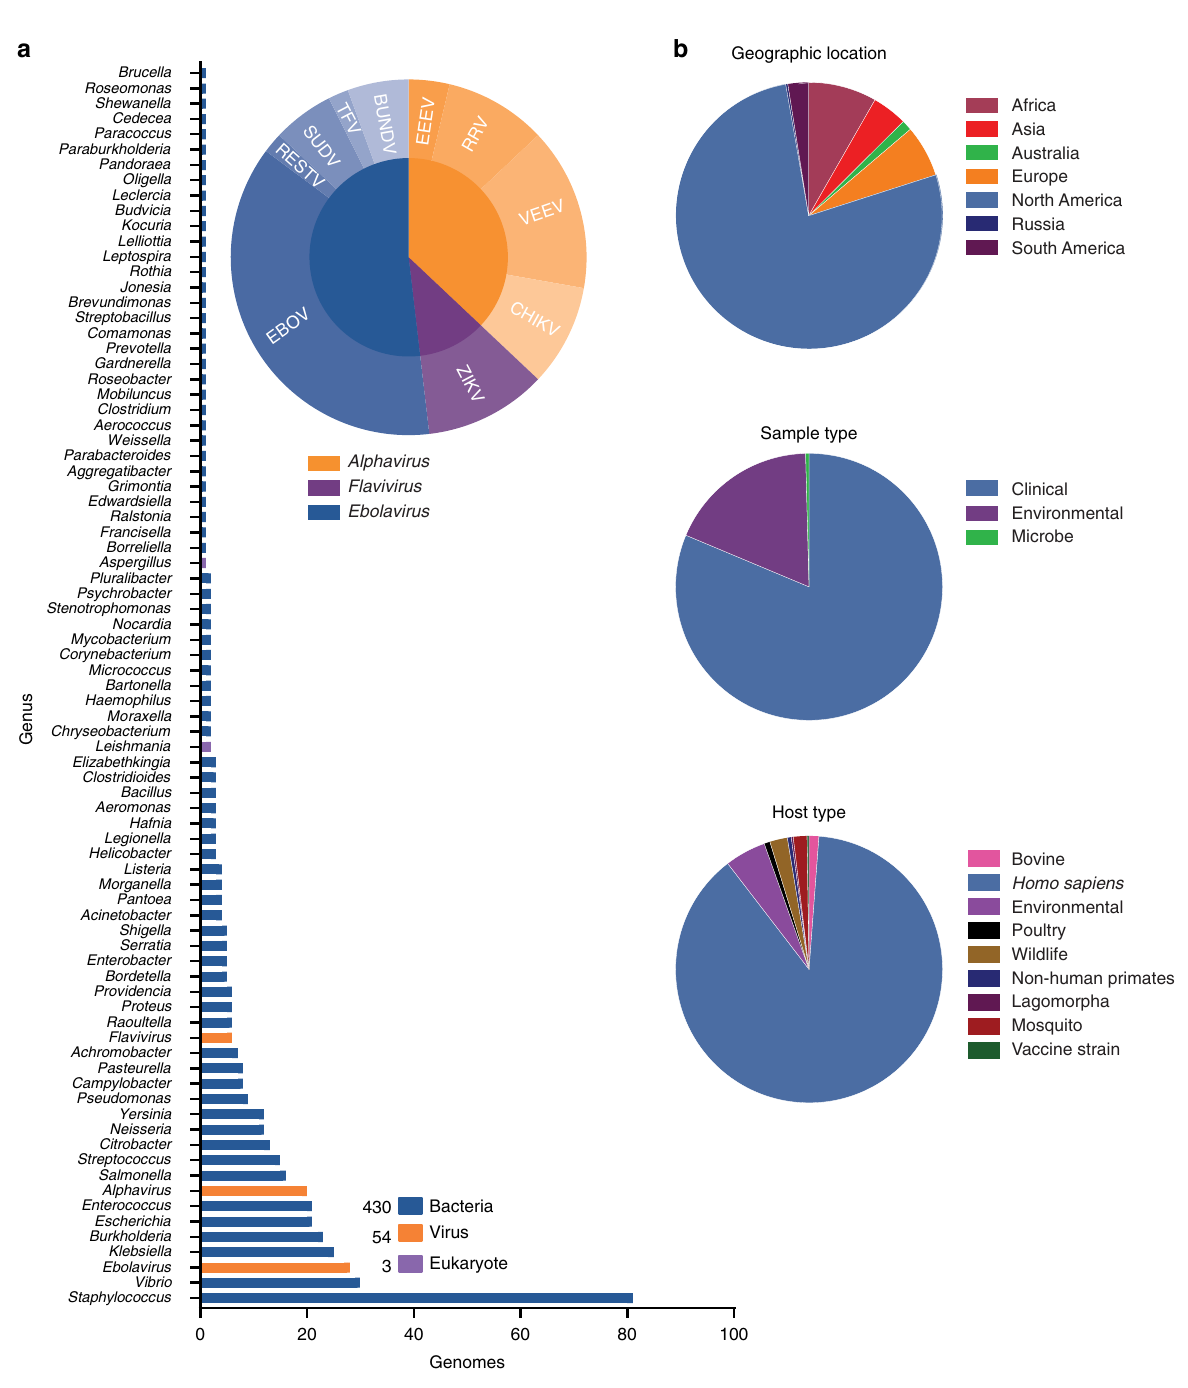
Fig. 2 FDA-ARGOS quality-controlled reference genomes for diagnostic use. Summary statistics of the current 487 microbial genomes show primary coverage of FDA-ARGOS resides with bacterial isolates, followed by viruses and then eukaryotic parasites ( a ). Supplementary Data 1 provides accessions for all 487 genomes currently available publicly. A majority of FDA-ARGOS constituents ( b ) originate from North America and are from human clinical